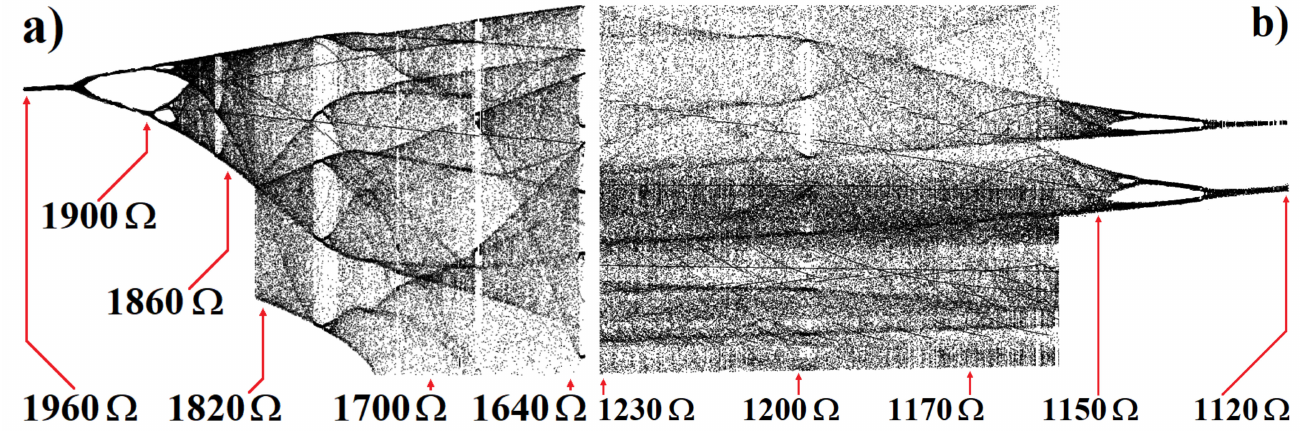
Figure 16. Darlington’s stage having output opened (that is infinite load resistance), 1D bifurcation diagram for narrow range of: ( a ) black resistor, ( b ) green